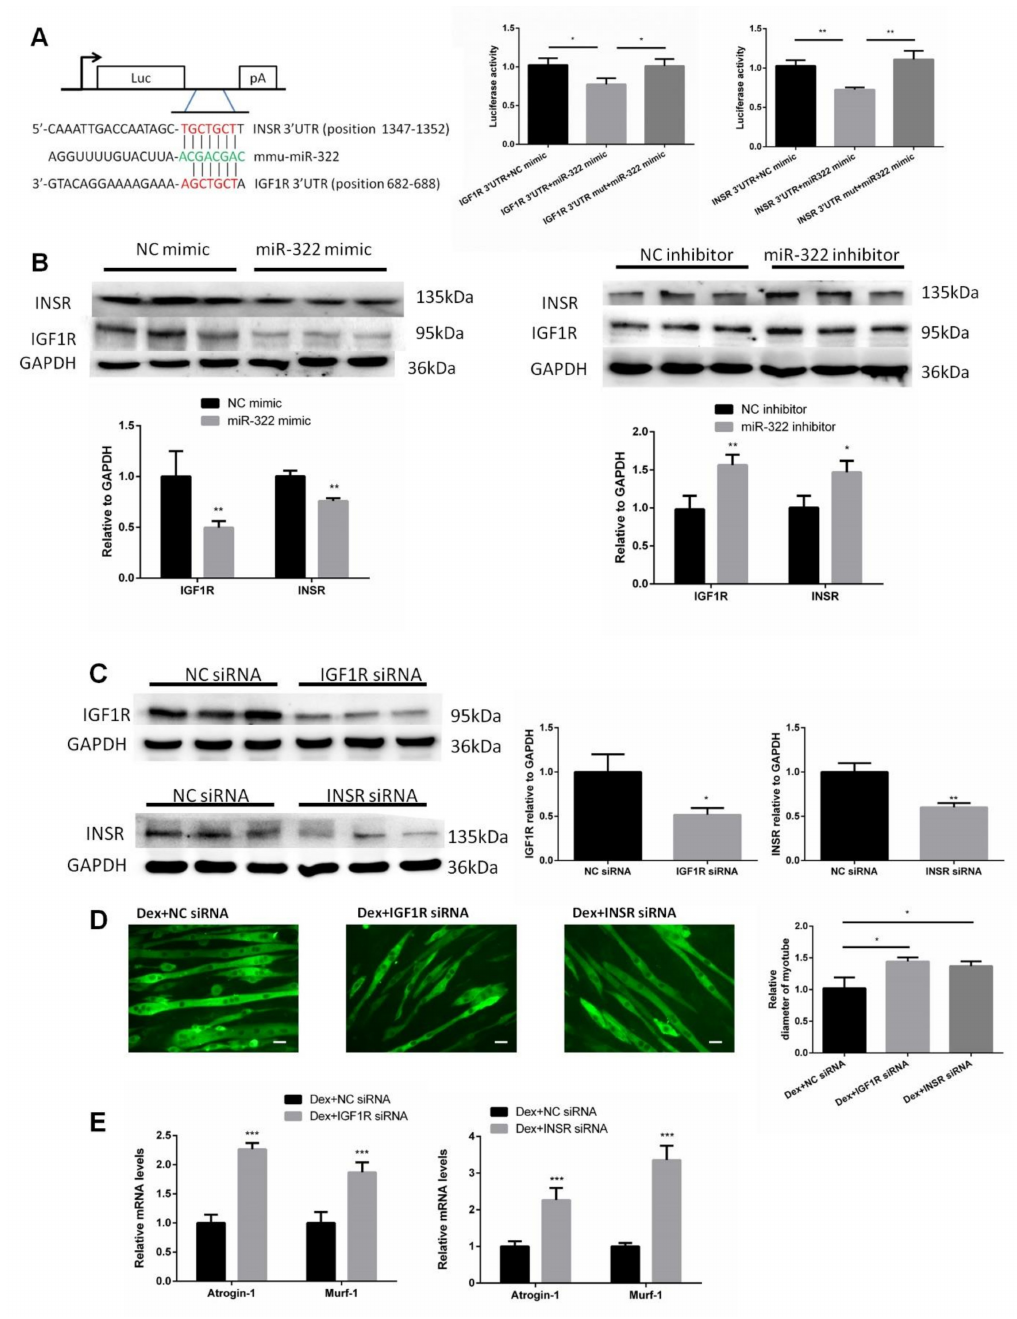
Figure 5. Insulin-like growth factor 1 receptor ( IGF1R ) and insulin receptor ( INSR ) of mice were identified as two target genes of miR-322. ( A ) TargetScan and luciferase reporter assay showed that IGF1R and INSR are two direct target genes of miR-322. ( B ) Western blot showed that miR-322 negatively regulated the expressions of IGF1R and INSR in the C2C12 myotubes. ( C ) The expressions of IGF1R and INSR were inhibited by siRNAs. ( D ) Immunofluorescent staining for MyHC in C2C12 myotubes showed that the inhibited expressions of IGF1R and INSR induced atrophy in the C2C12 myotubes. ( E ) qPCR analysis showed the inhibited expressions of IGF1R and INSR induced by the upregulation of Atrogin-1 and MuRF-1 in C2C12 myotubes. Scale bar, 10 µ m. NC, negative control. Dex, dexamethasone. * p < 0.05, ** p < 0.01, and *** p <